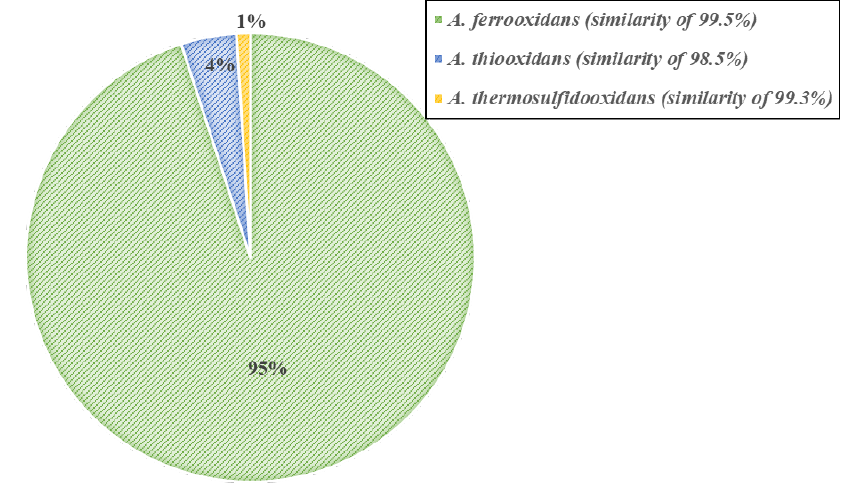
Figure 4. Microbial profiling of the four-step adapted bacteria.